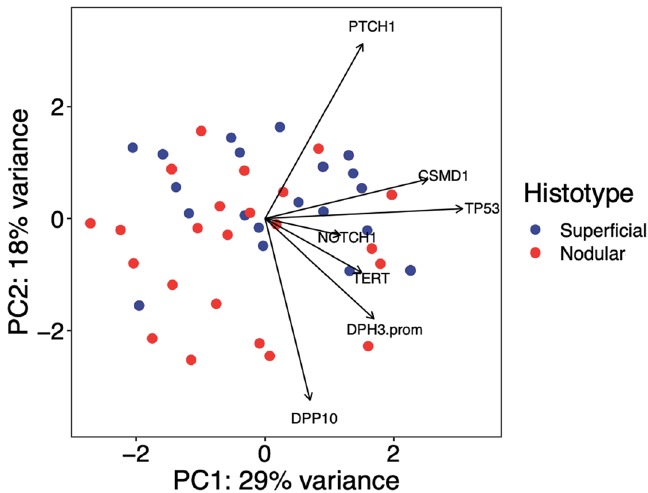
Figure 3. Two-dimensional principal component analysis (PCA) of genetic variations among superficial and nodular subtypes. Each sample was characterized as a distinct dot in a vector space. PTCH1 mutations characterized the superficial BCC types that clustered on the top right of the graph (PTCH1 arrow). Over 47% of the variance in genetic profile data sets were accounted for by the first two components: PC1 (29%) and PC2